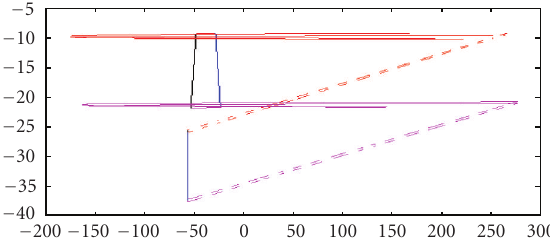
Figure 4.5. The quadrangle (cid:2) D and its image under the mapping (cid:2) P 4 .